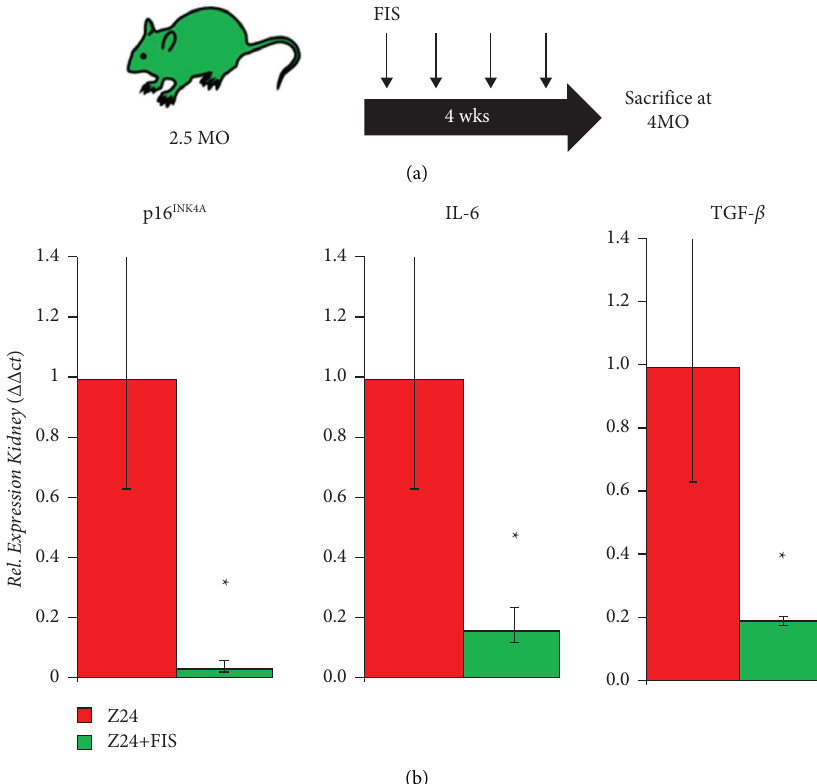
Figure 4: Fisetin reduces senescence-associated transcripts. (a) Weekly dosing strategy for FIS treatments. (b) qPCR data for senescence marker p16INK4A and proinfammatory SASP factors IL-6 and TGF- β . Quantifcation based on ΔΔ Ct method for relative gene expression ( n � 3, ∗ P ≤ 0 .